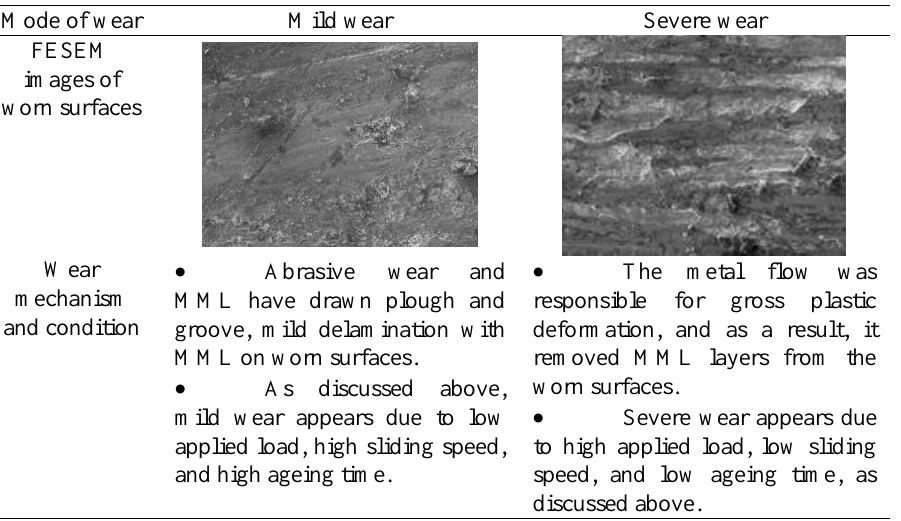
Table 1. Mode of wear and wear